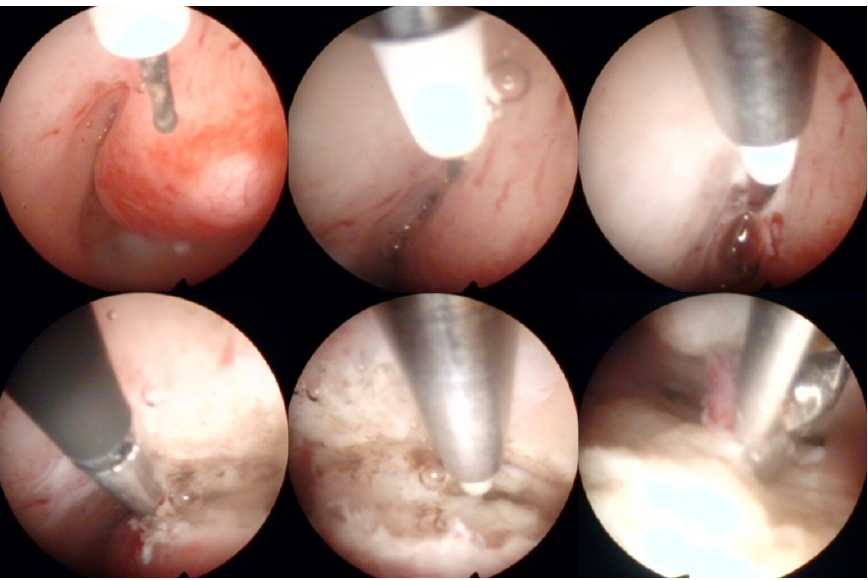
Figure 4. Operative hysteroscopic removal of an endometrial polyp (mean diameter 13 mm) by Versapoint system (Gynecare, Ethicon Inc., NJ, USA). Intraoperative photographs by F.B. and S.F.